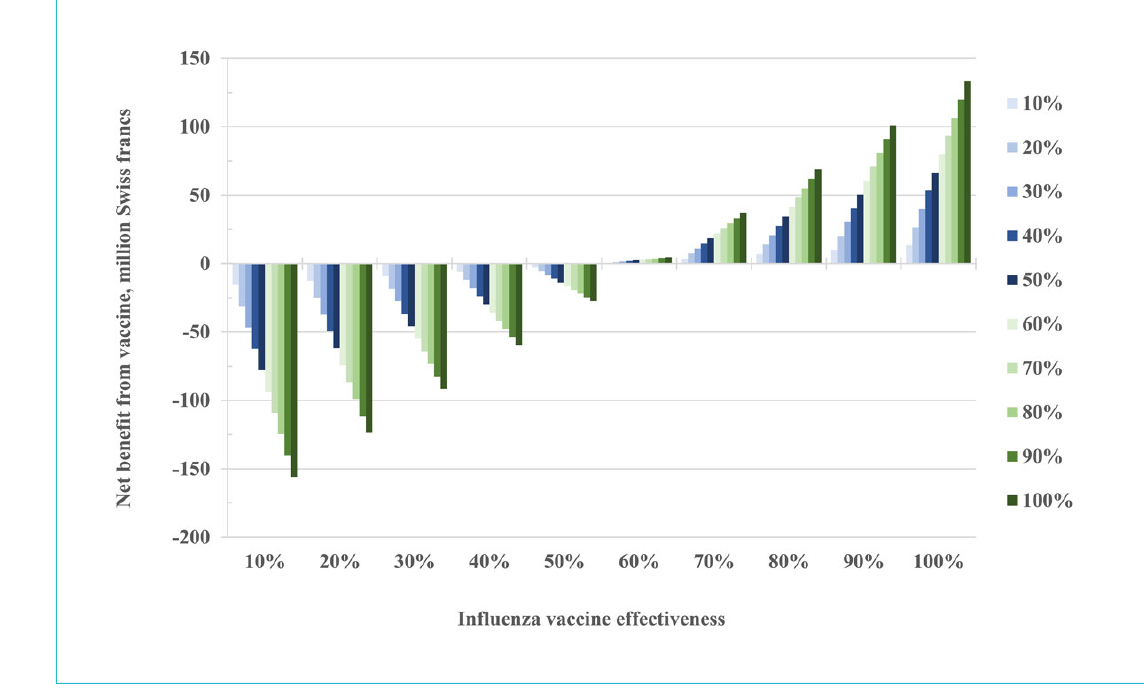
Figure 1: Expected net economic benefit from influenza vaccination in the group of healthy adults aged 19‒65 years in relation to vaccine ef- fectiveness. The different colours indicate vaccination coverage rates in the